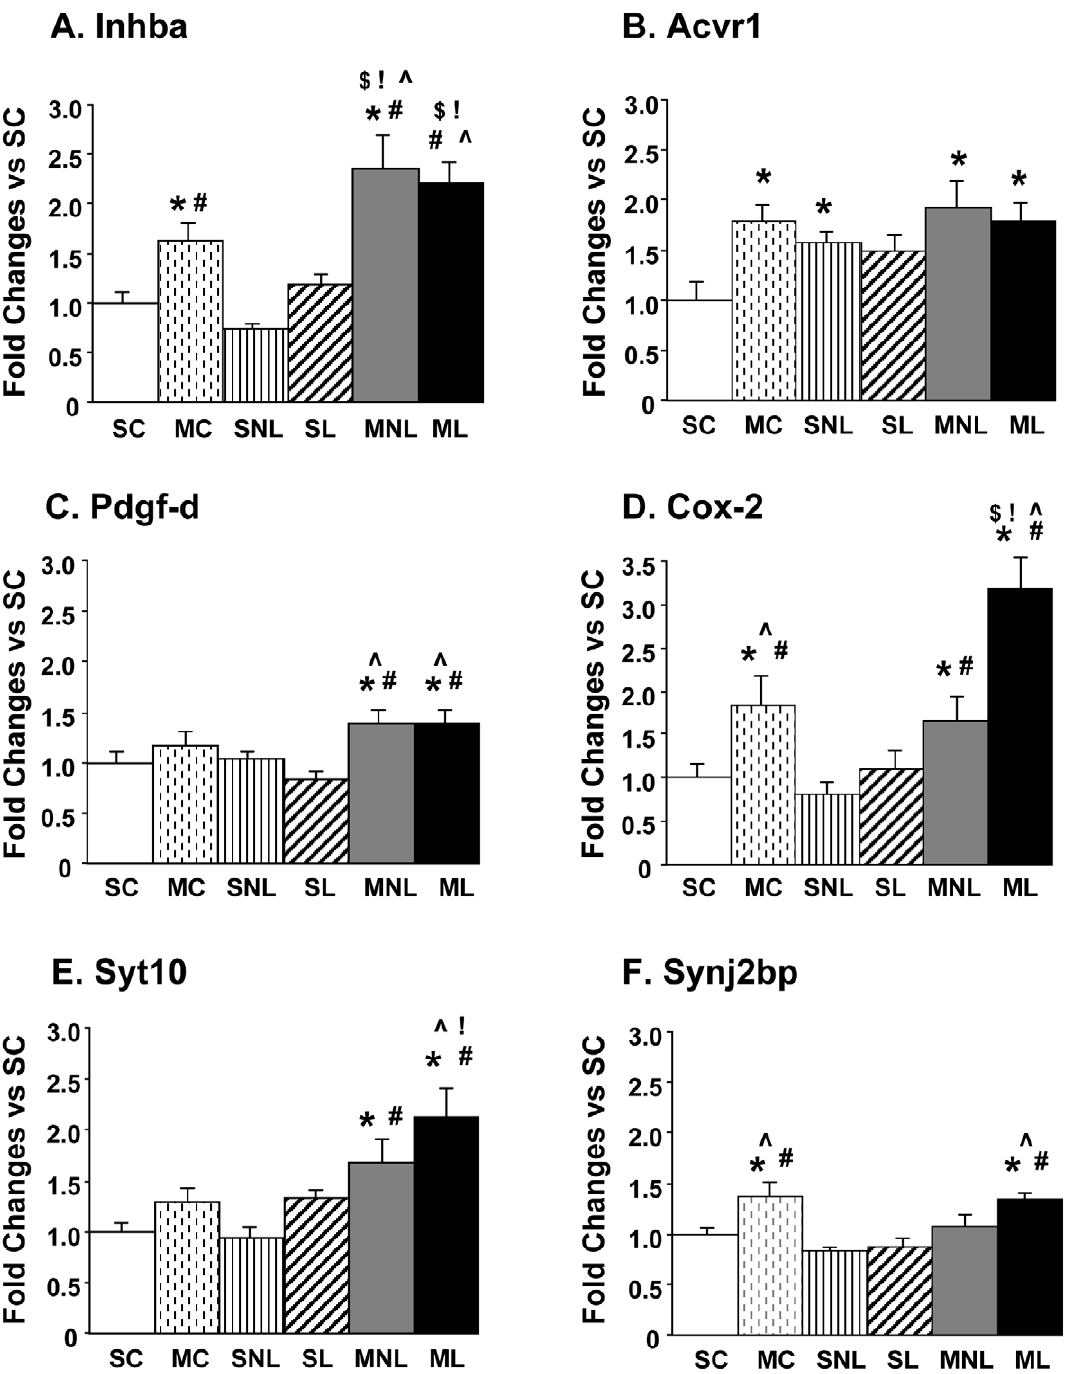
Figure 4. Effects of METH on the expression of Inhba,Acvr1,Pdgf-d,Cox-2,Syt and Synj2bp in DA-depleted striatum. The values represent means 6 SEM (fold changes in comparison to the SC group) of 6–10 measurements. Statistical analyses were done by ANOVA followed by PLSD. Key to statistics: *p , 0.05,in comparison to the SC group; # p , 0.05, in comparison to the SNL group; !p , 0.05, in comparison to the MC group; ^p , 0.05, in comparison to the SL group; $ p , 0.05, in comparison to the MNL group.